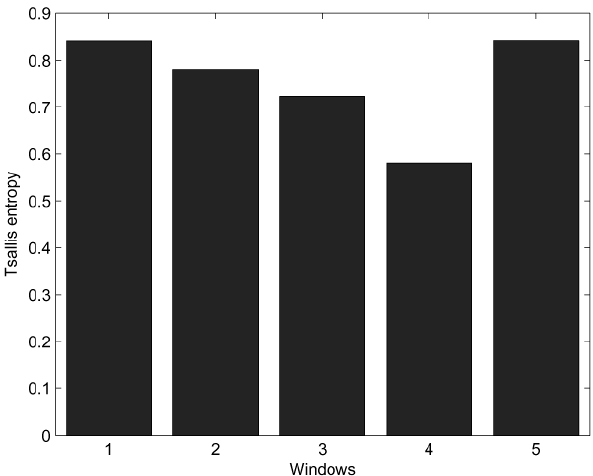
Fig. 10. Entropy values for five window intervals for the most quiet day in January 2011 from detrended TEC taken from Birnin Kebbi.